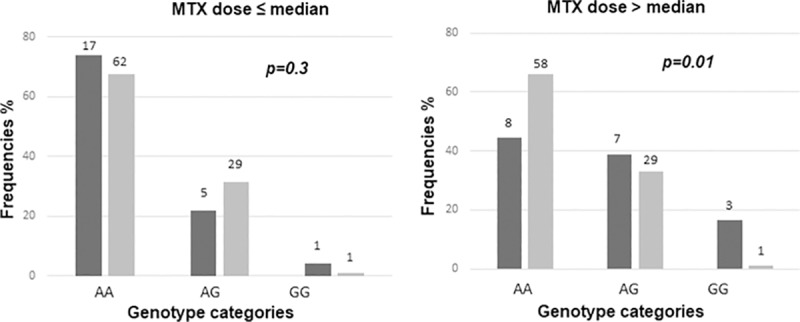
Interaction between MTR rs1805087 and cumulative methotrexate dose.The frequency of each genotype in affected and non-affected group defined by verbal fluency score is presented by black and gray bars, respectively, in the groups that received cumulative MTX below median (left panel) or above median (right panel). The number of individuals represented by each bar and p values are indicted on the plot. OR for interaction is 3.3, 95% CI 0.9–11.5, p = 0.07, as derived from logistic regression model including MTR genotype, cumulative MTX dose and interaction term.